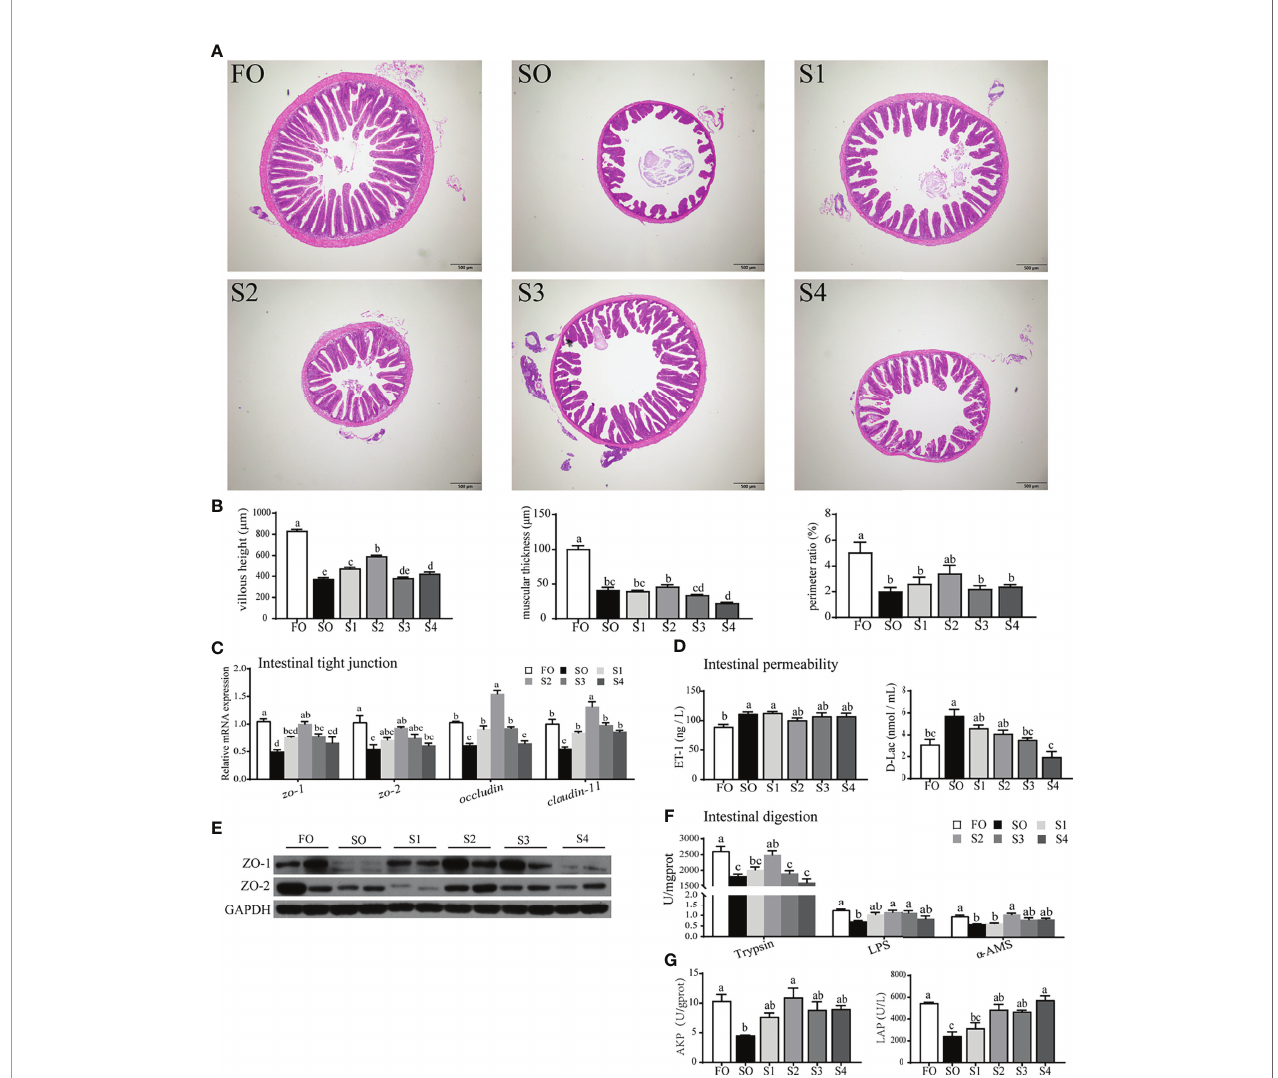
FIGURE 1 | Octanoate supplementation alleviated dietary SO-induced intestinal physical barrier damage and digestive capacity decrease. Histopathological changes in the intestine tissue from the experimental groups were observed by H&E staining (A) and assessed by indices of villus height (VH), muscular thickness (MT), and perimeter ratio (PR) (B) . The relative mRNA expression of tight junction protein ( zo-1 , zo-2 , occludin , and claudin-11 ) in the intestinal tissue were measured (C) . The protein expression of tight junction protein (ZO-1 and ZO-2) in the intestinal tissue were measured (n = 2) (E) . The level of ET-1 and D-Lac in the serum were measured (D) . The enzymic activities of Trypsin, LPS, and a -AMS in the intestinal tissue (F) , and LAP, AKP in intestinal brush margin were measured (G) . Data were presented as means ± S.E.M. Means in each bar sharing the same superscript letter or absence of superscripts were not signi fi cantly different determined by Tukey ’ s test ( P ≥ 0.05). S.E.M.: standard error of means (n =